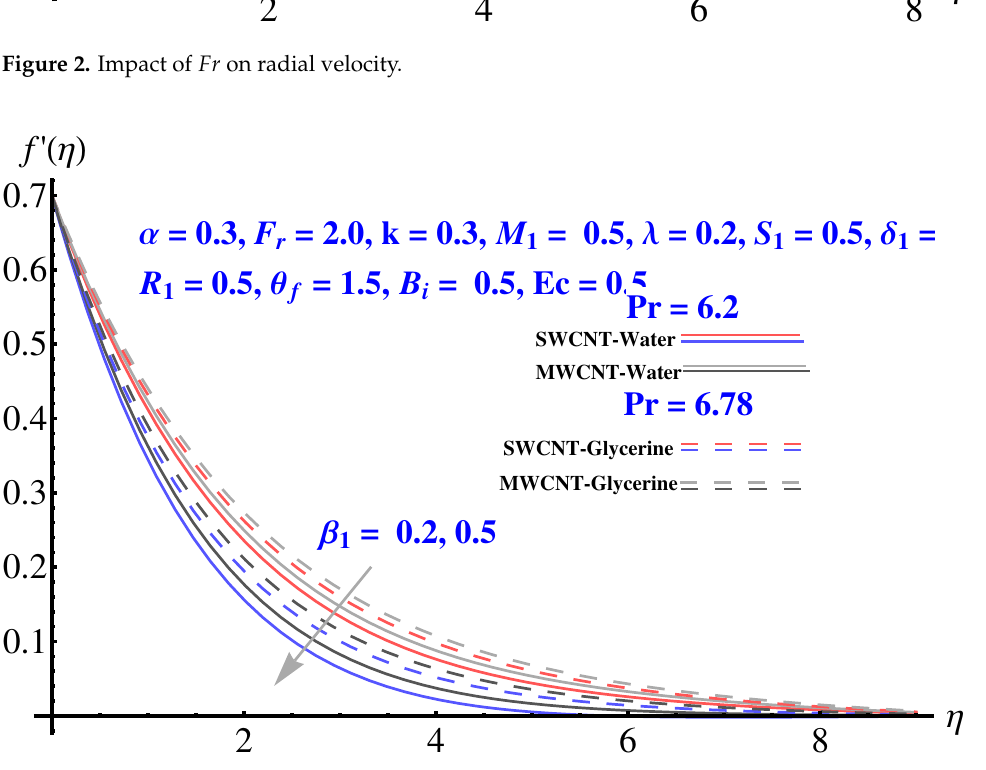
Figure 3. Impact of β 1 on radial